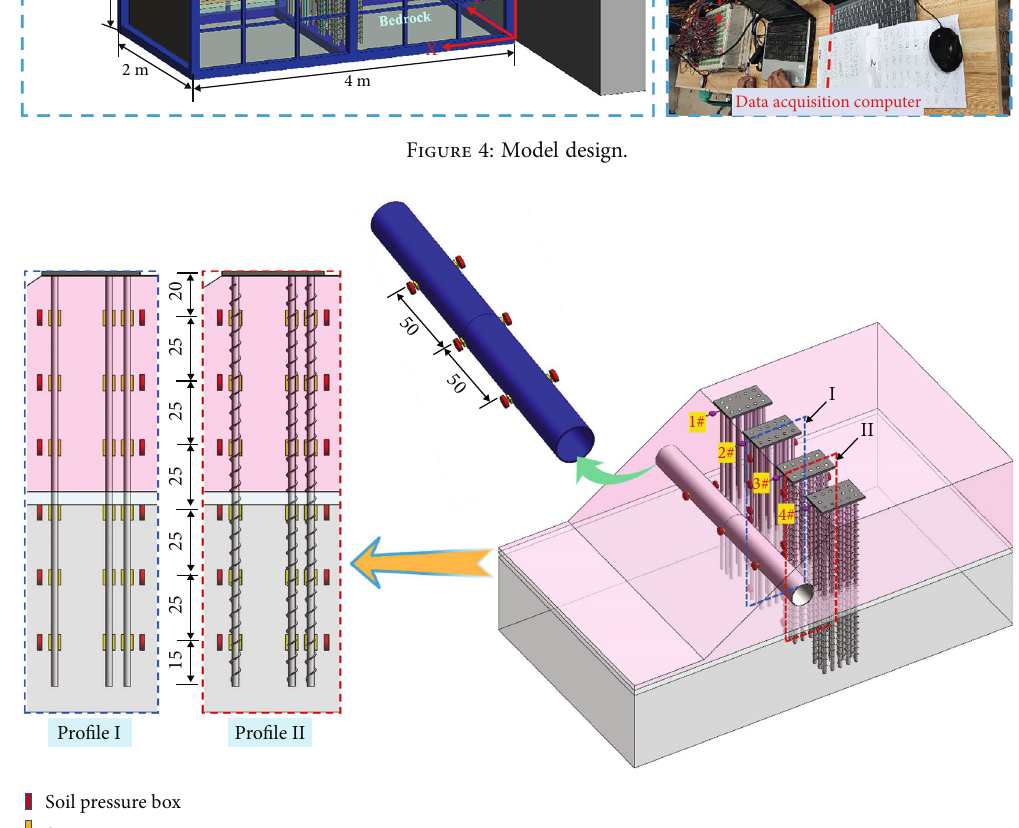
Figure 5: Sensor location layout